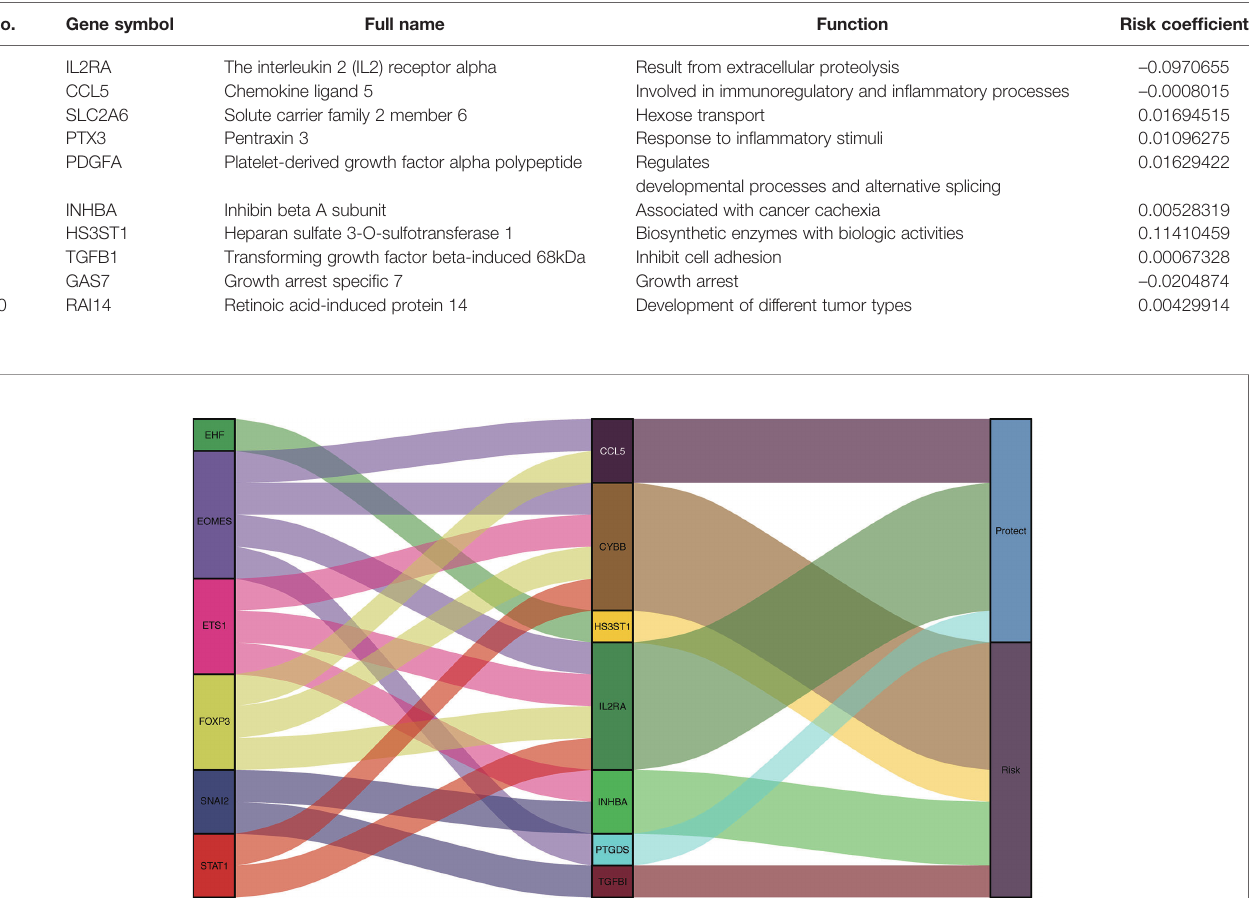
TABLE 2 | Functions of MGMs in the prognostic gene signatures.